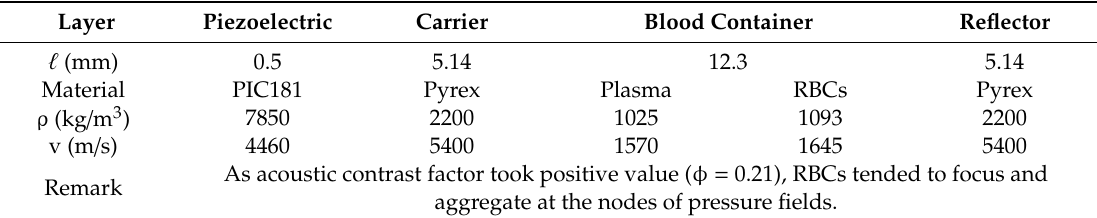
Table 1. Summary of size and material property of an ultrasonic transducer.